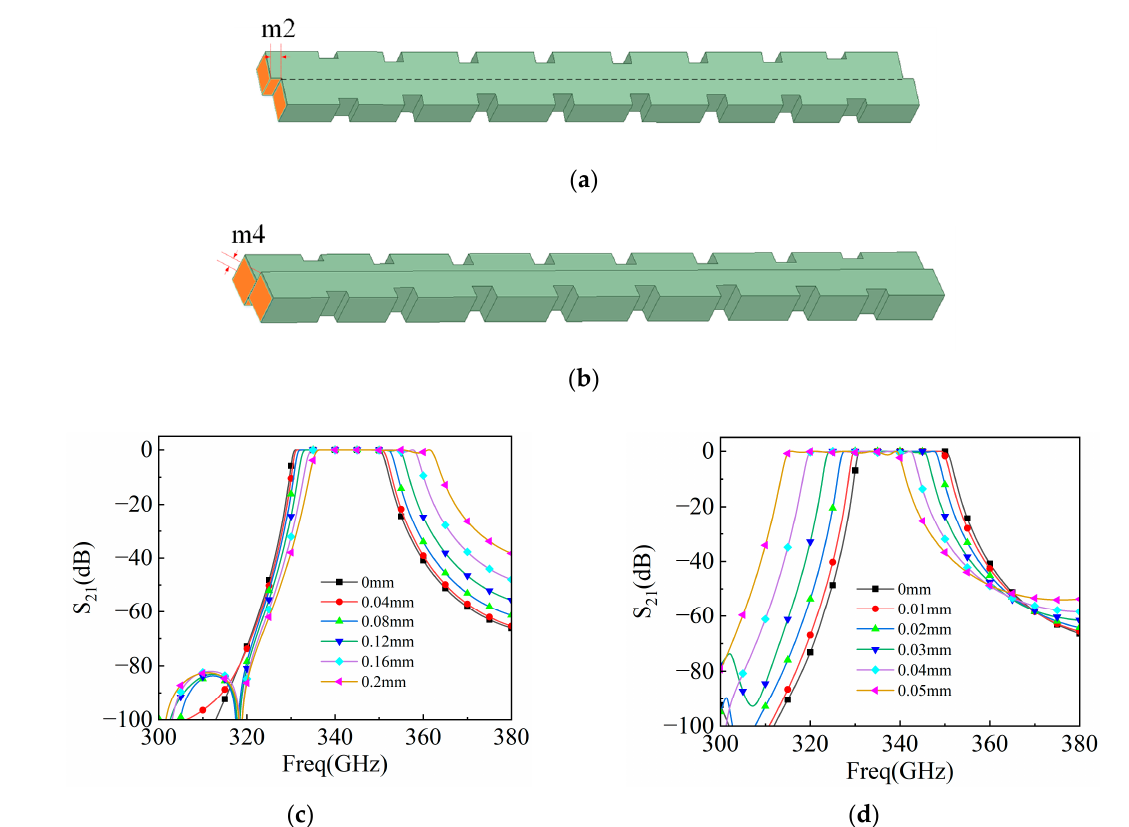
Figure 8. The filter structure and S 21 changes with asymmetry. ( a ) Filter structure of horizontal shift; ( b ) filter structure of vertical shift; ( c ) S 21 changes with m 2 ; ( d ) S 21 changes with m 4 .